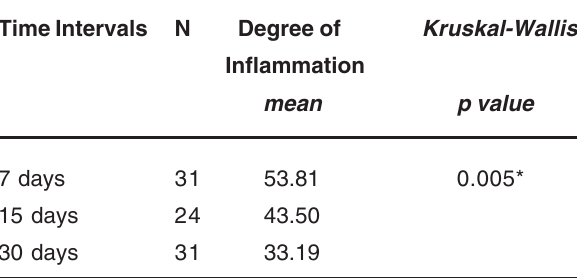
FIGURE 2- Demonstrative image of tissue reaction, considered severe, when using chlorhexidine associated with calcium hydroxide at 7 days. Abscess presence considered score 2 (arrow)